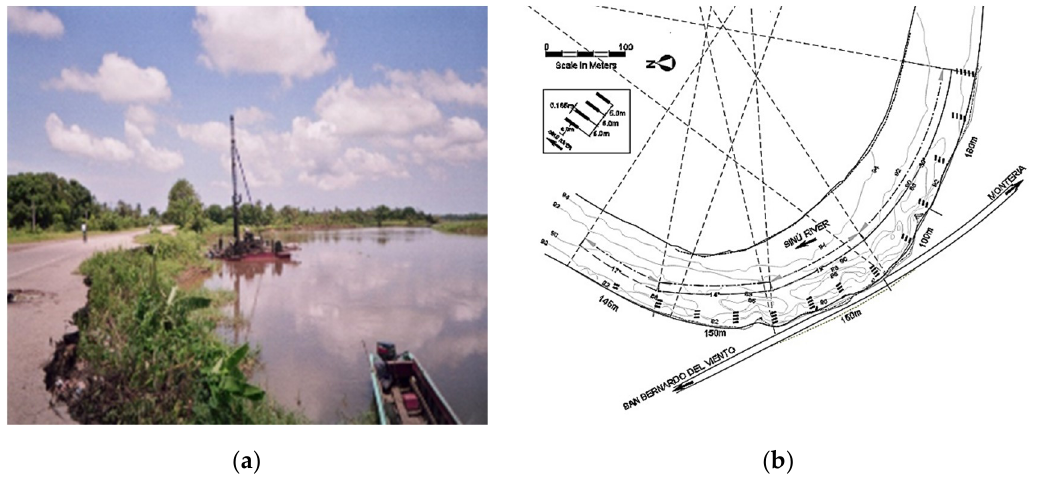
Figure 6. Sinú River, Trementino: ( a ) condition at the start of the project; ( b ) representative geometry used in the design (Hidroconsulta, 2004). Table 1. Sin ú River, Trementino: design of the submerged vane field (Hidroconsulta, 2004 [10]). Sector